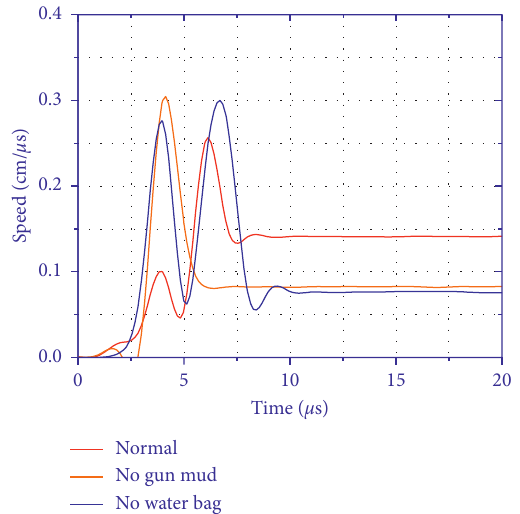
Figure 22: Comparison of maximum velocity curves.